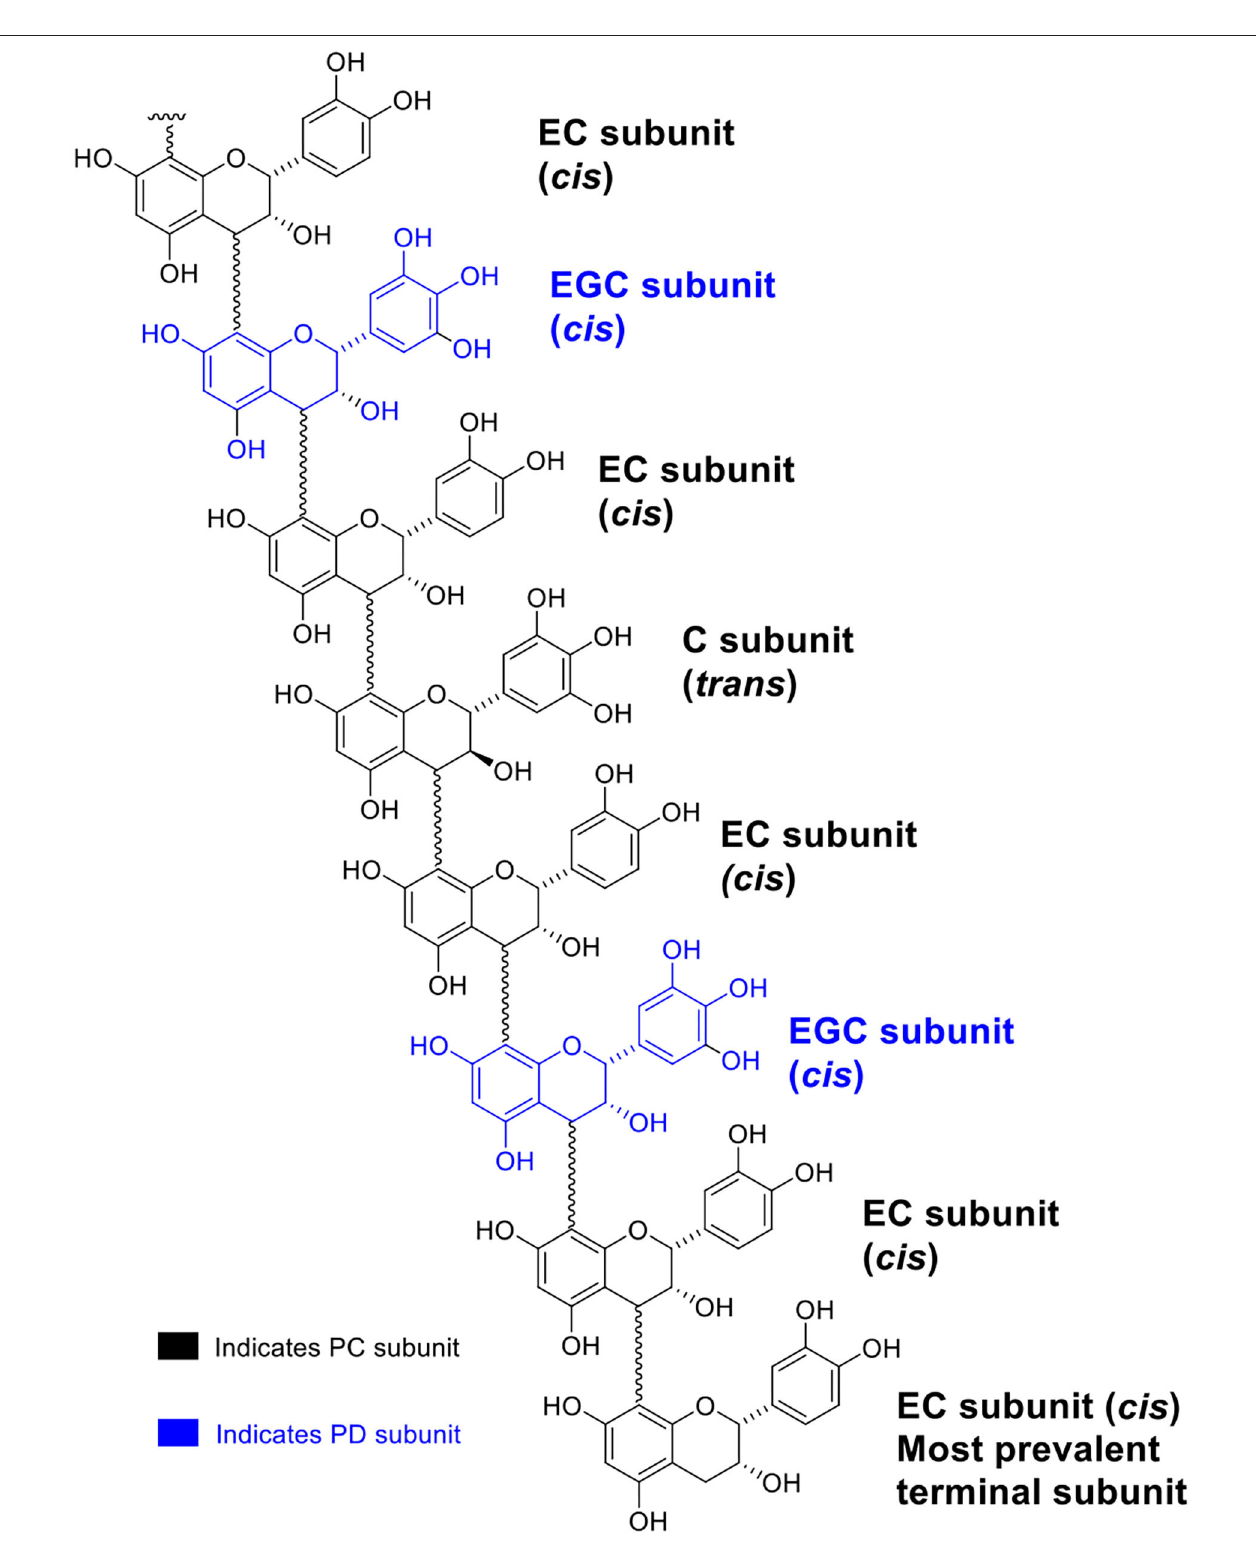
FIGURE 1 | A generic structure illustrating the multitude of flavan-3-ol subunits of CT from PPC ( Dalea purpurea Vent.).